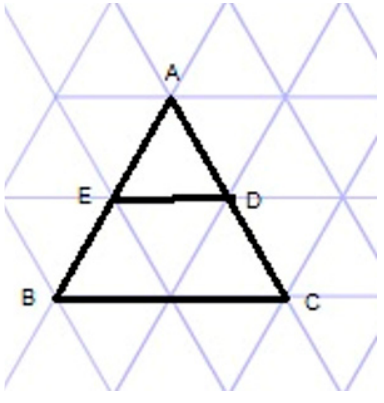
Figure 3. The third ornamentation. Figure 4. The fourth ornamentation.